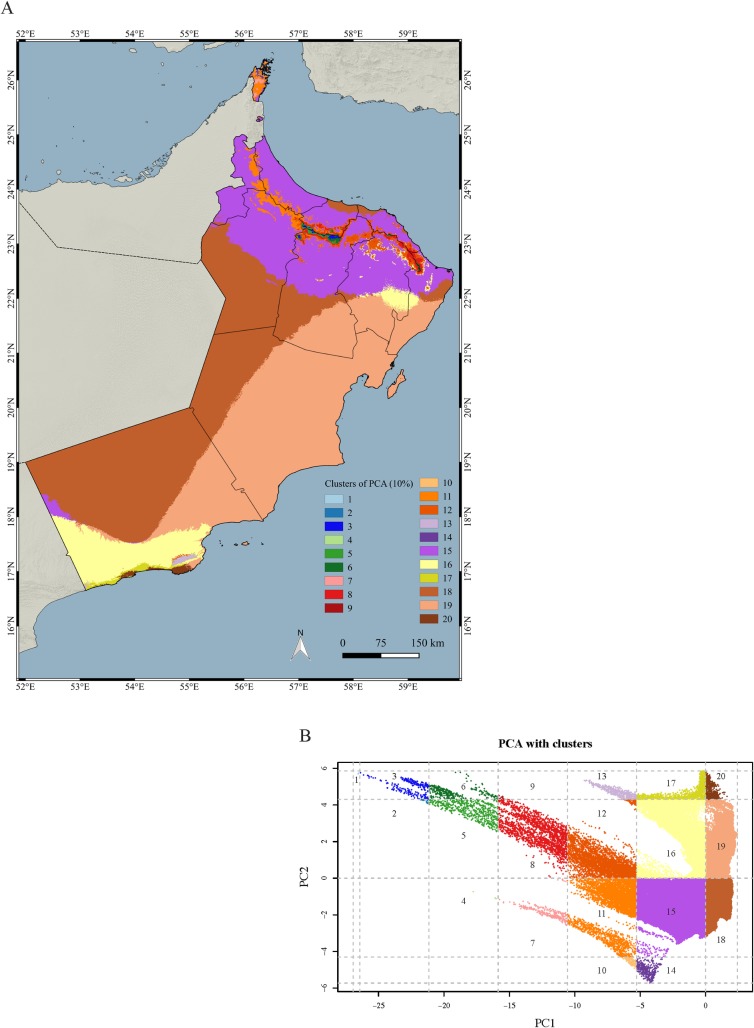
Climate variability of Oman.(A) Map showing the distribution and extension of the 20 climatic clusters of Oman identified in this study that group 10% of the explained variance by PC1 and PC2; (B) Principal Component Analysis (PCA) of the climatic space of Oman using 12 BIOCLIM variables and with the 20 climatic clusters that group 10% of the explained variance by PC1 and PC2 with the same colors as in the map. Clusters have been numbered from 1 to 20 with the following order: from left to right and from bottom to top.